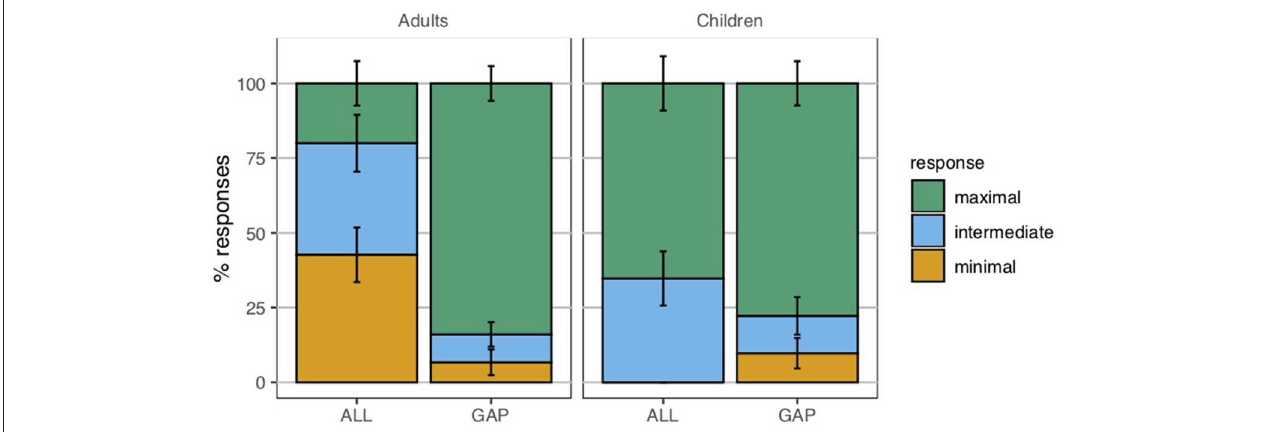
FIGURE 11 | Percentages of the reward types given in the existential certains “some” conditions. The ALL context corresponded to the scalar implicature targets, and the GAP context corresponded to the incomplete description controls . Minimal or intermediate rewards for existentially quantified sentences in ALL contexts were indicative of scalar implicatures. A less-than-maximal reward for existential descriptions of GAP contexts was indicative of incomplete description